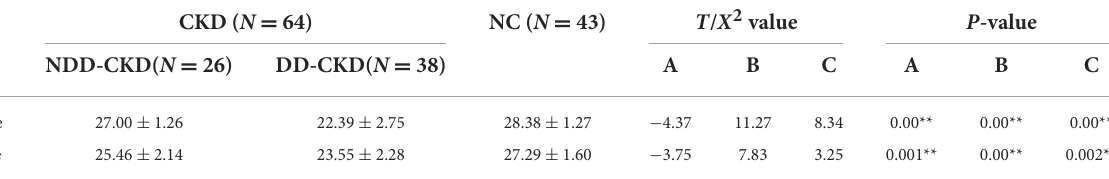
TABLE 3 Cognitive scores of the CKD and NC